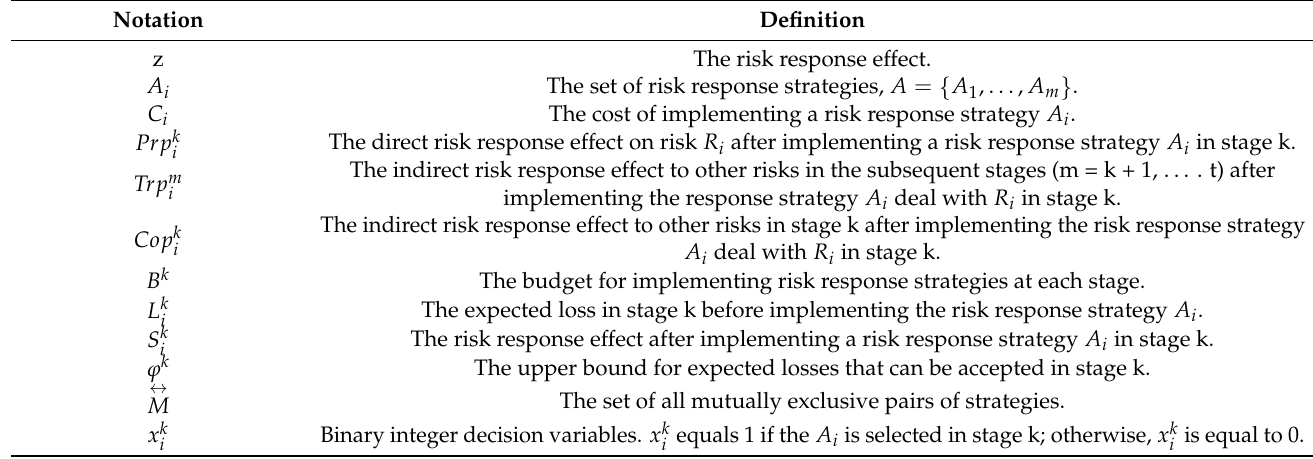
Table 4. The notation and